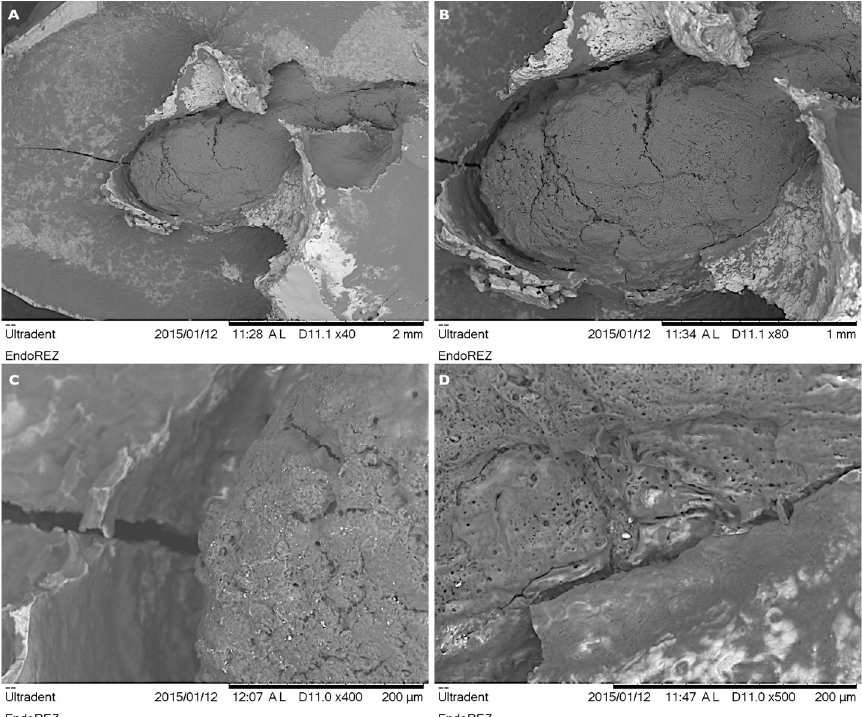
Figure 3. The appearance of ER filler localized in the center of the resorbed root at ×40 ( A ) and ×80 ( B ) magnification. The porous, resorbed surface profile of the ER material at magnifications of ×400 ( C ) and ×500 ( D ).